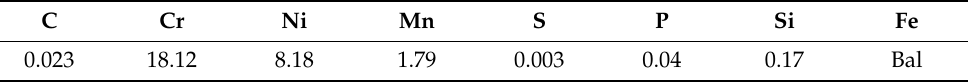
Table 1. Chemical composition of experimental material AISI 304L (in wt. %, provided by supplier).